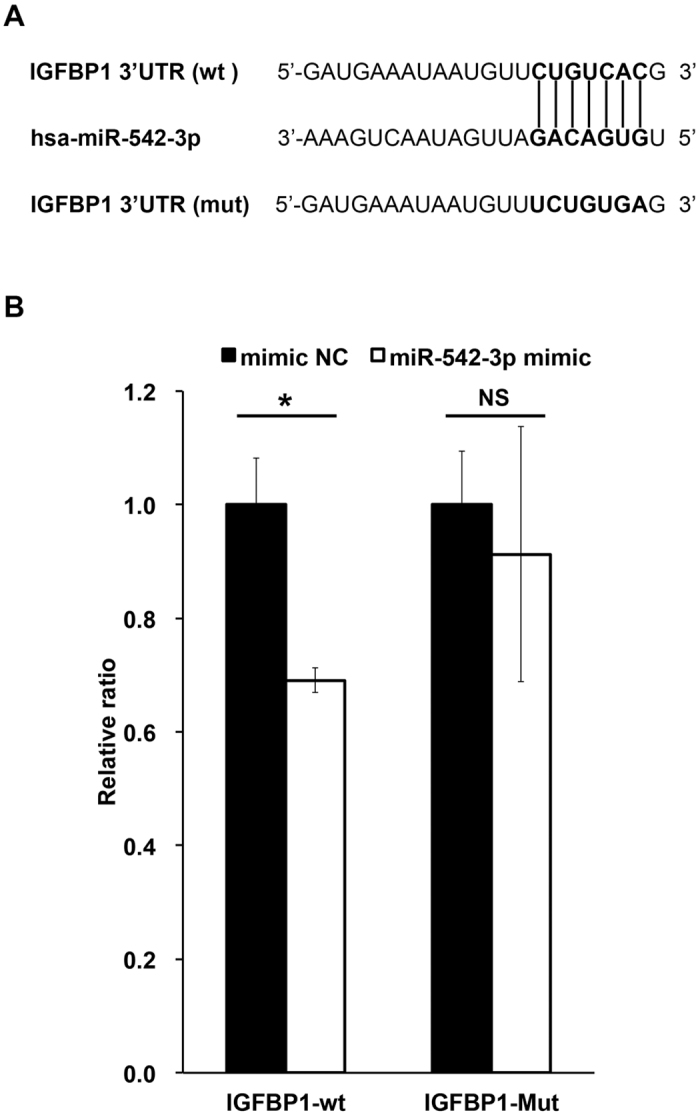
IGFBP1 is a direct target of miR-542-3p.(A) The predicted target sequence of miR-542-3p in the 3′ untranslated region (UTR) of IGFBP1 and the mutated sequence used in the luciferase assay are shown. (B) Relative luciferase activity of IGFBP1-wt and IGFBP1-mut reporter vectors co-transfected with miR-542-3p mimic (miR-542-3p) or negative control (NC) miRNA in decidualized HESCs. Using IGFBP1-wt vector, the relative luciferase activity was decreased by 31% upon transfection with miR-542-3p compared to NC mimic. The IGFBP1-mut reporter was not significantly inhibited by miR-542-3p mimic. Data are shown as the mean ± SEM of three independent experiments. *P < 0.05; NS, Not significantly different.